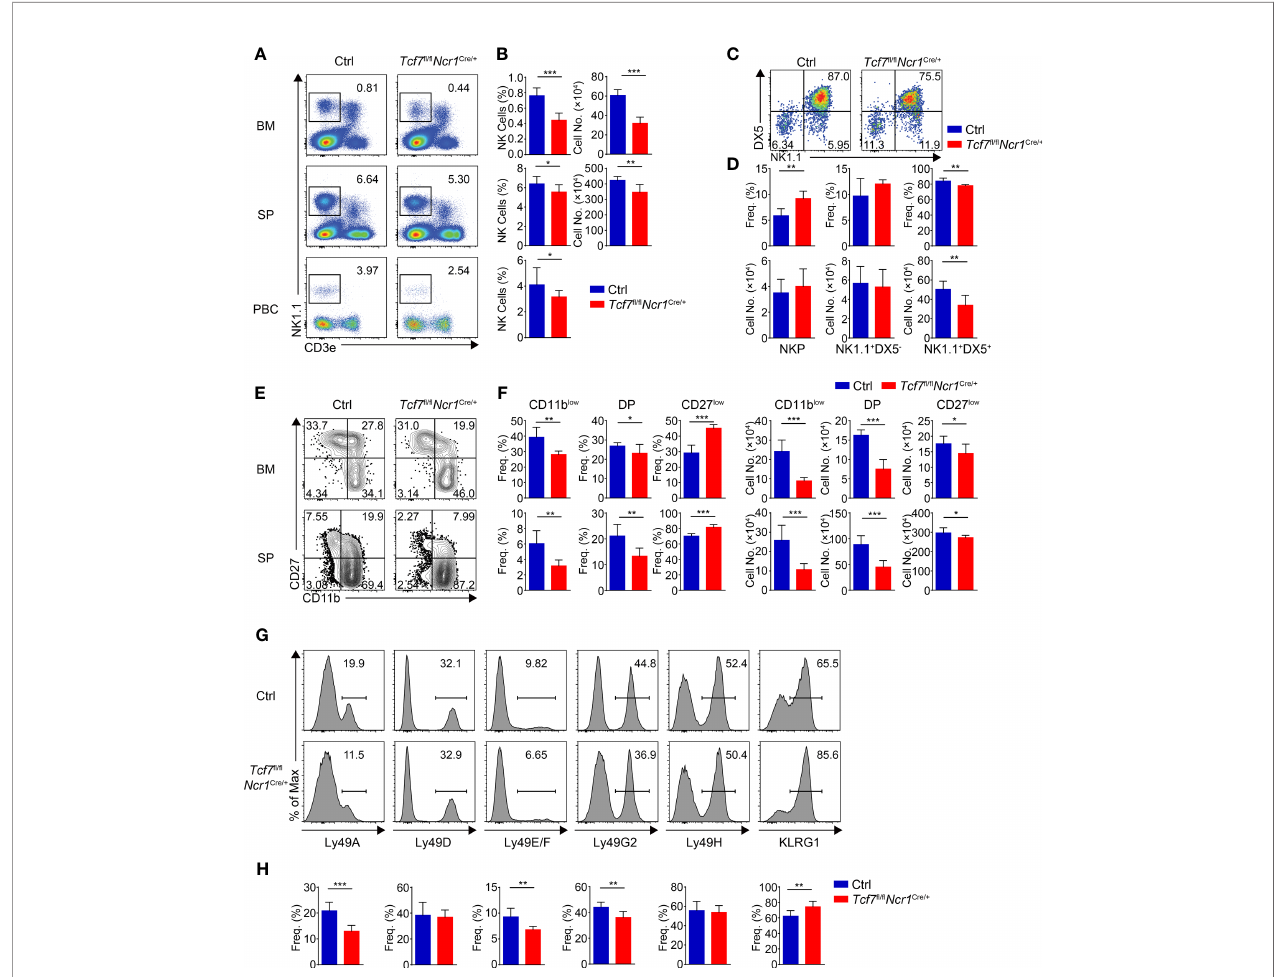
FIGURE 4 | Lacking Tcf1 only in Ncr1 + cells leads to modest defects in NK cell development. (A) Flow cytometry analysis of BM, SP, and PBCs from Ctrl and Tcf7 fl / fl